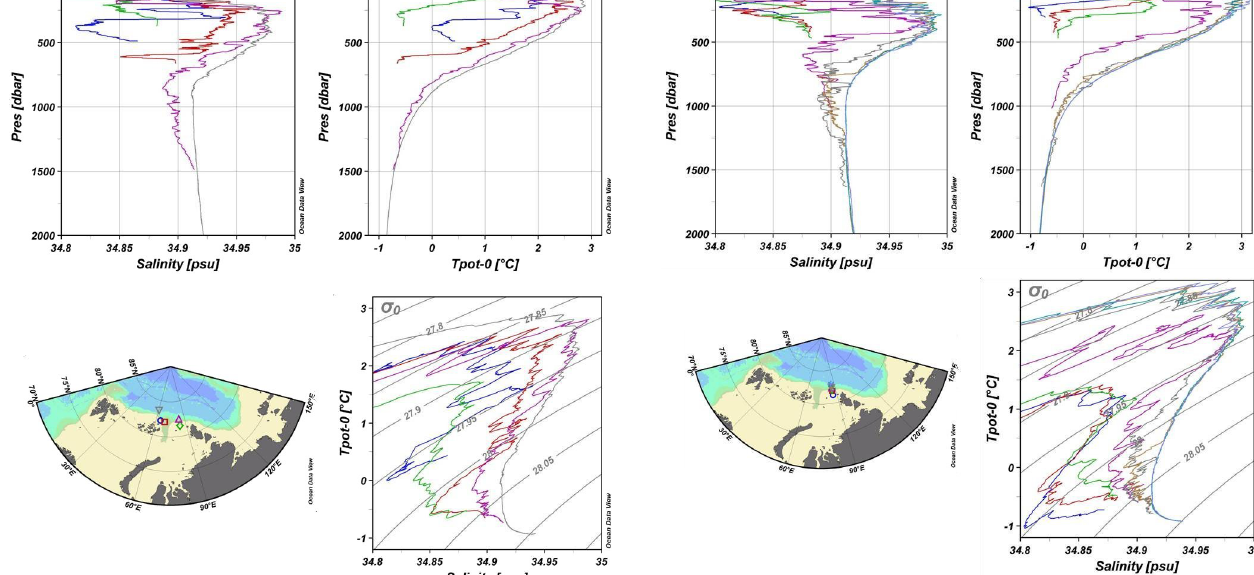
Fig. 8 . Profiles of salinity and potential temperature and θS curves from the Nansen Basin (grey station) and from the shelf (blue sta- tion) north of Franz Josef Land and from St. Anna Trough (red sta- tion) showing the warmer Fram Strait branch Atlantic water and the denser water on the shelf and the Fram Strait branch water enter- ing the trough from the north. The green and magenta stations on the Kara Sea shelf and slope show the Barents Sea branch remain- ing on the shelf, but the denser part of the Barents Sea inflow is seen as a low salinity layer at the slope between 750m and 1500m (magenta station).